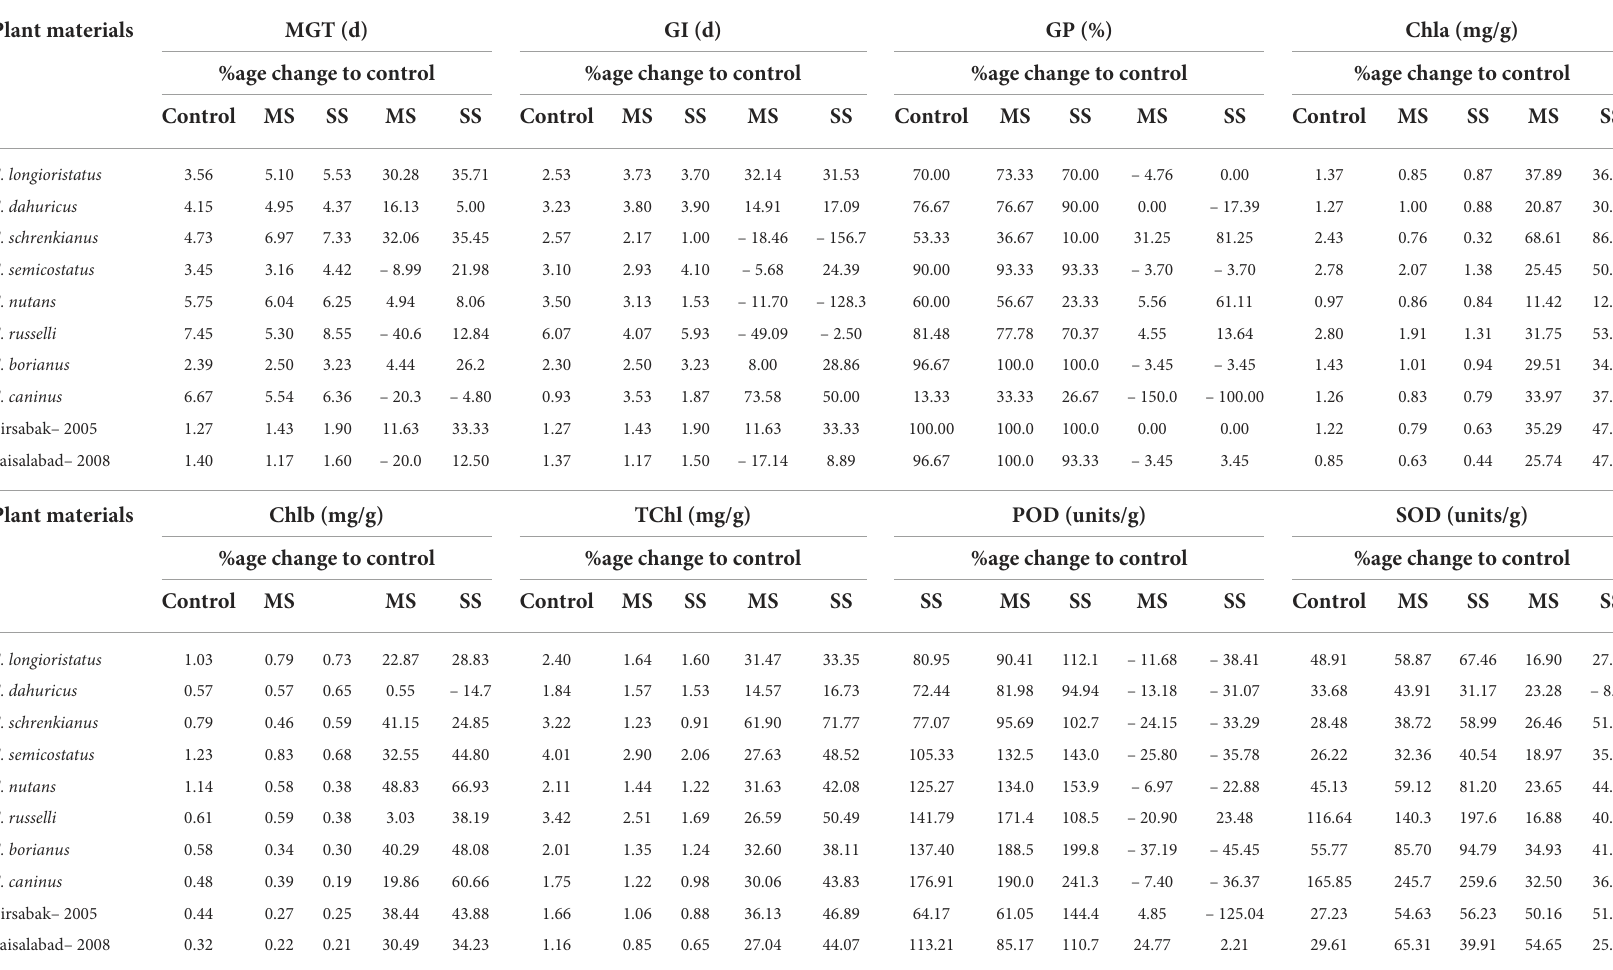
TABLE 3 Variability in mean germination time, germination index, germination percentage, chlorophyll contents, and antioxidants enzymatic activities among Elymus species and wheat cultivars under drought stress. Plant